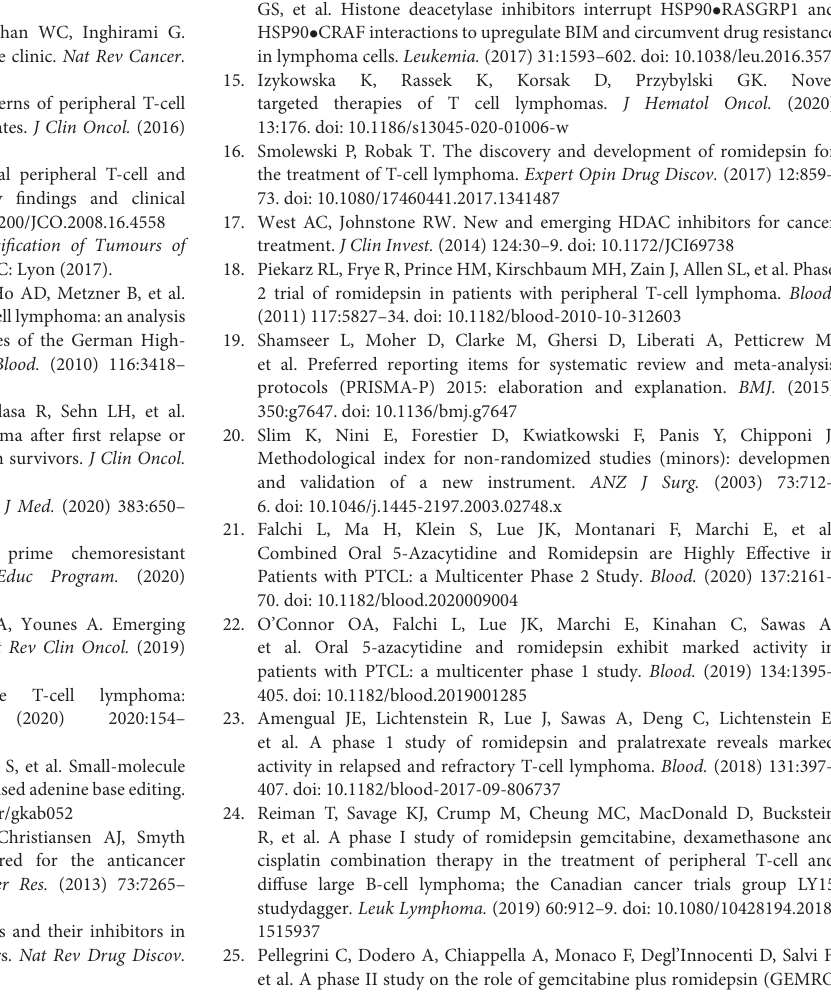
Supplementary Figure S1 | Forest plots for sensitivity analysis of CR, PR, 2-year OS and 2-year PFS. (A) Forest plot of CR (random effects model); (B) Forest plot of PR (random effects model); (C) Forest plot of 2-year OS (fixed effects model); (D) Forest plot of 2-year PFS (random effects model). Supplementary Figure S2 | Contour-enhanced funnel plots for sensitivity analysis of CR, PR, 2-year OS and 2-year PFS. (A) Contour-enhanced funnel plot for complete response (CR); (B) Contour-enhanced funnel plot for partial response (PR); (C) Contour-enhanced funnel plot for 2-year overall survival (OS); (D) Contour-enhanced funnel plot for 2-year progression-free survival (PFS). Supplementary Figure S3 | Forest Plots for Over Proportion of Adverse Events in treatment with romidepsin combined with other drugs. (A) Proportion of all-grade adverse events in treatment with romidepsin combined with other drugs; (B) Proportion of grade 3 or higher adverse events in treatment with romidepsin combined with other